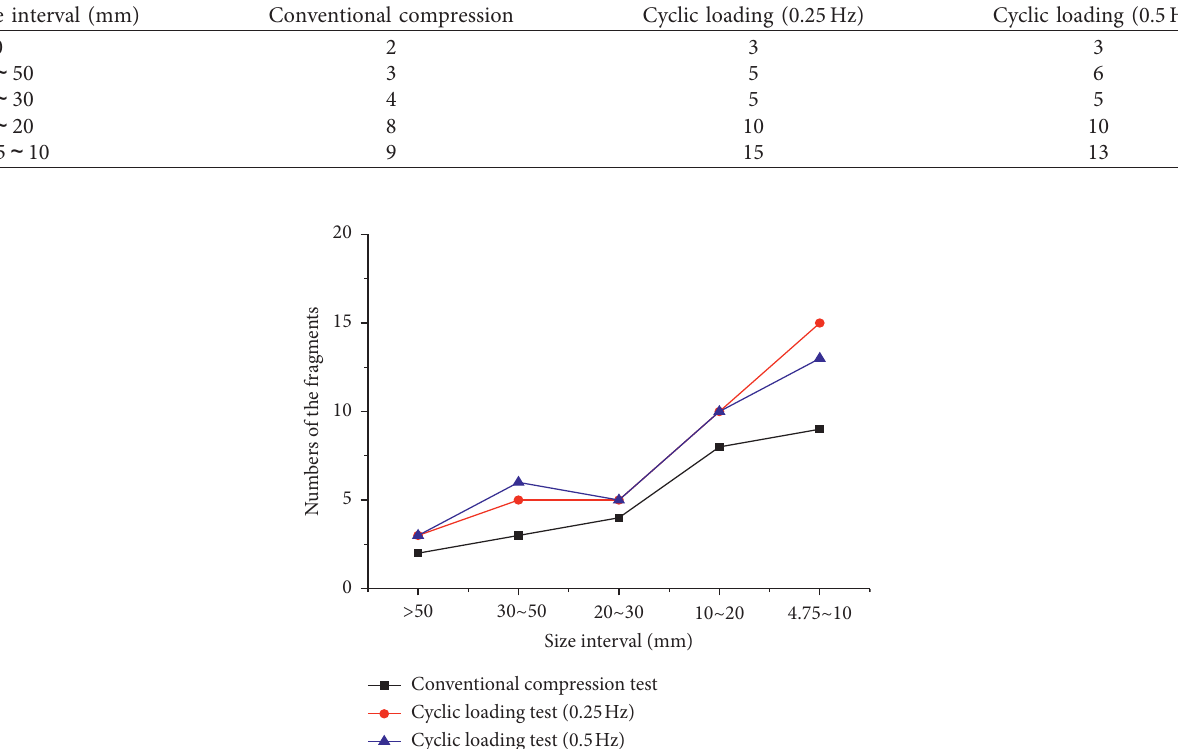
Figure 8: Number of limestone specimen fragments within different size intervals obtained under different test conditions.